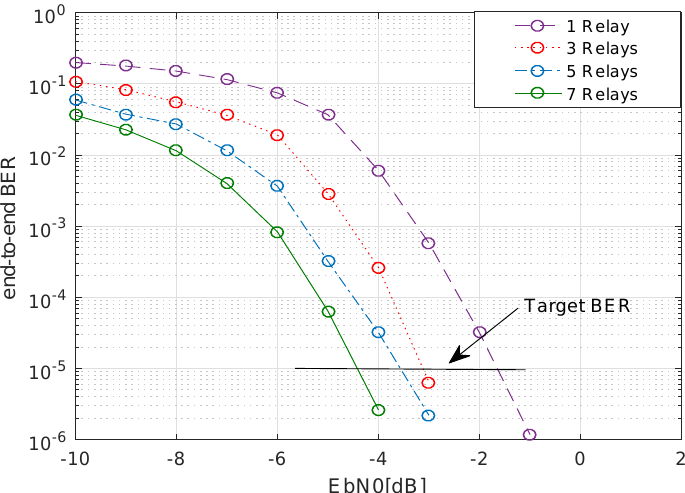
Figure 4. EPA-I (equal power allocation): BER of system with multiple relays with an equal transmit power, code rate 1/2, codeword length n = 648, Nakagami- m fading, m 1 = m 2 = 3, and 4-QAM.